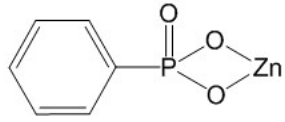
Figure 1. Chemical structure of zinc phenylphosphonate (brand TMC).